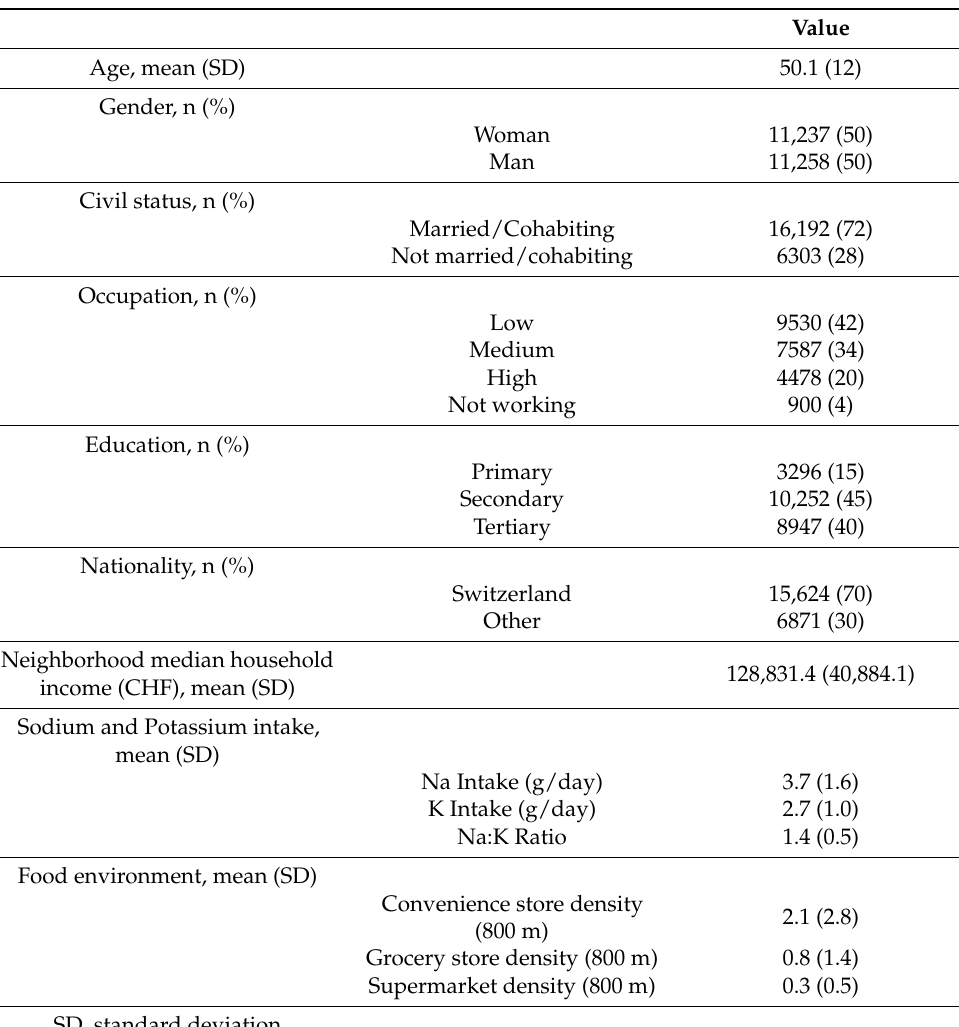
Table 1. Individual and neighborhood characteristics of the Bus Sant é study participants 1993–2018 (N =